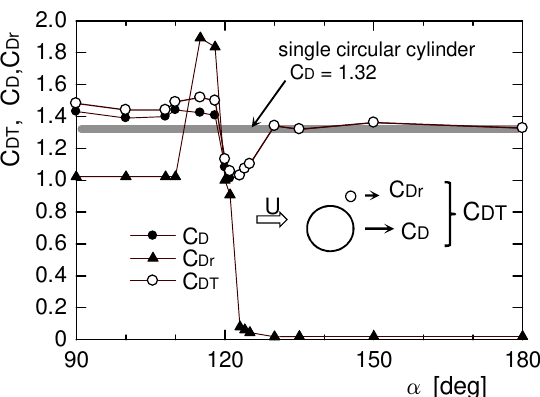
Fig. 6. Pressuer distribution of the small rod for each flow patterns (D = 40 mm, d = 2 mm, G = 6 mm, U = 16 m / s) .